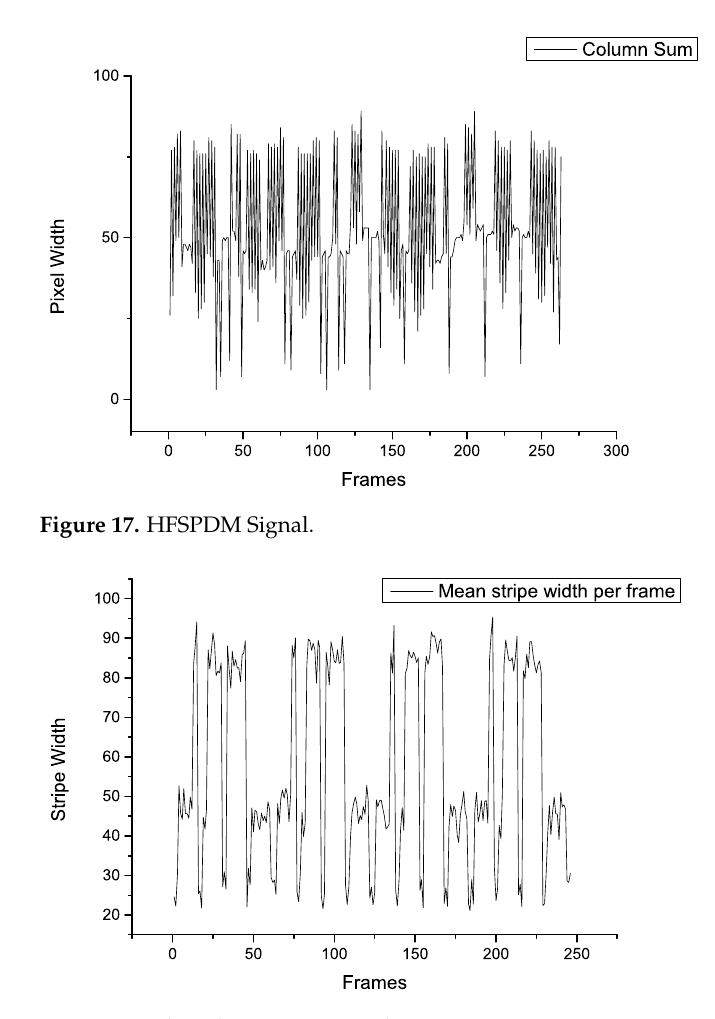
Figure 18. Filtered HFSPDM